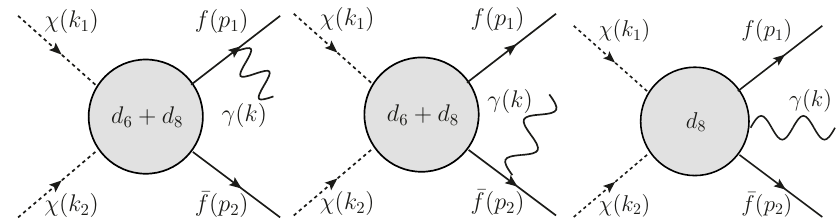
Figure 1 . Feynman diagrams for dark matter annihilation into a fermion-anti-fermion pair and a photon. The dark matter, fermion, anti-fermion and the photon are denoted by (cid:31) , f , (cid:22) f and (cid:13) respectively. The four-momentum associated with each particle is given in parenthesis next to the particle. The operator which contributes to the Feynman diagram is written in the